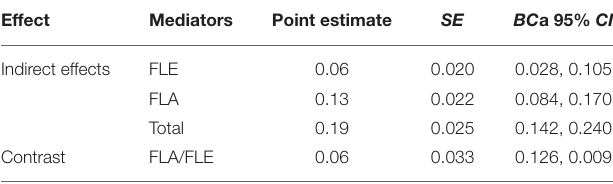
TABLE 6 | Analysis of mediating effects of FLE and FLA between grit and